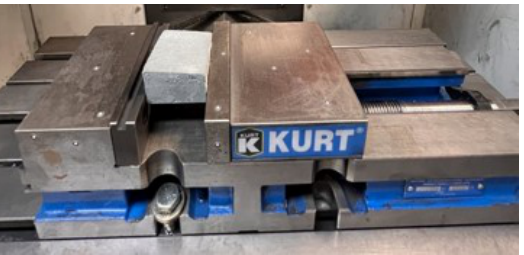
Figure 4. Infiltrated sample clamped in milling machine vise on machine table [19].